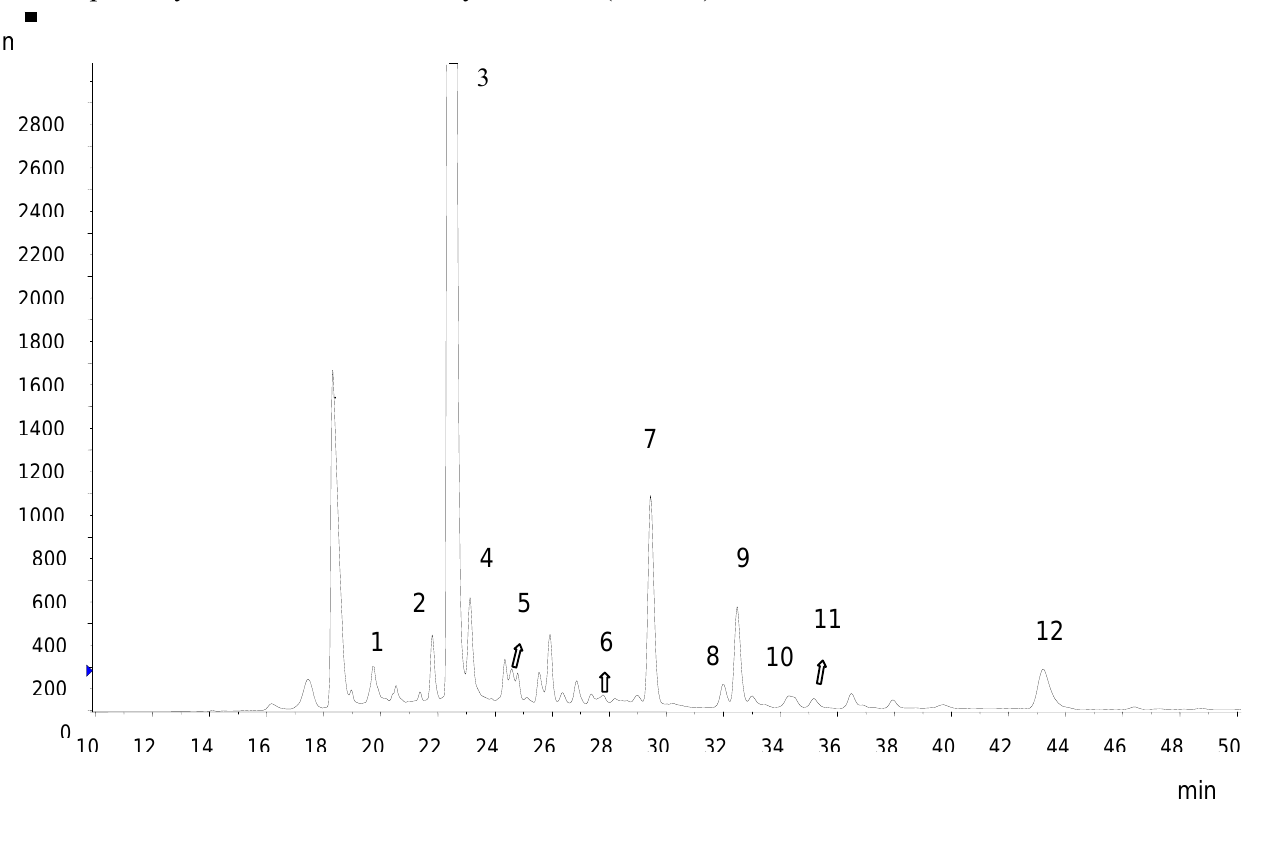
Figure 2. Separation of phenolic acids and other flavonoids extracted from Amazon grape peels by HPLC with diode array detection (320